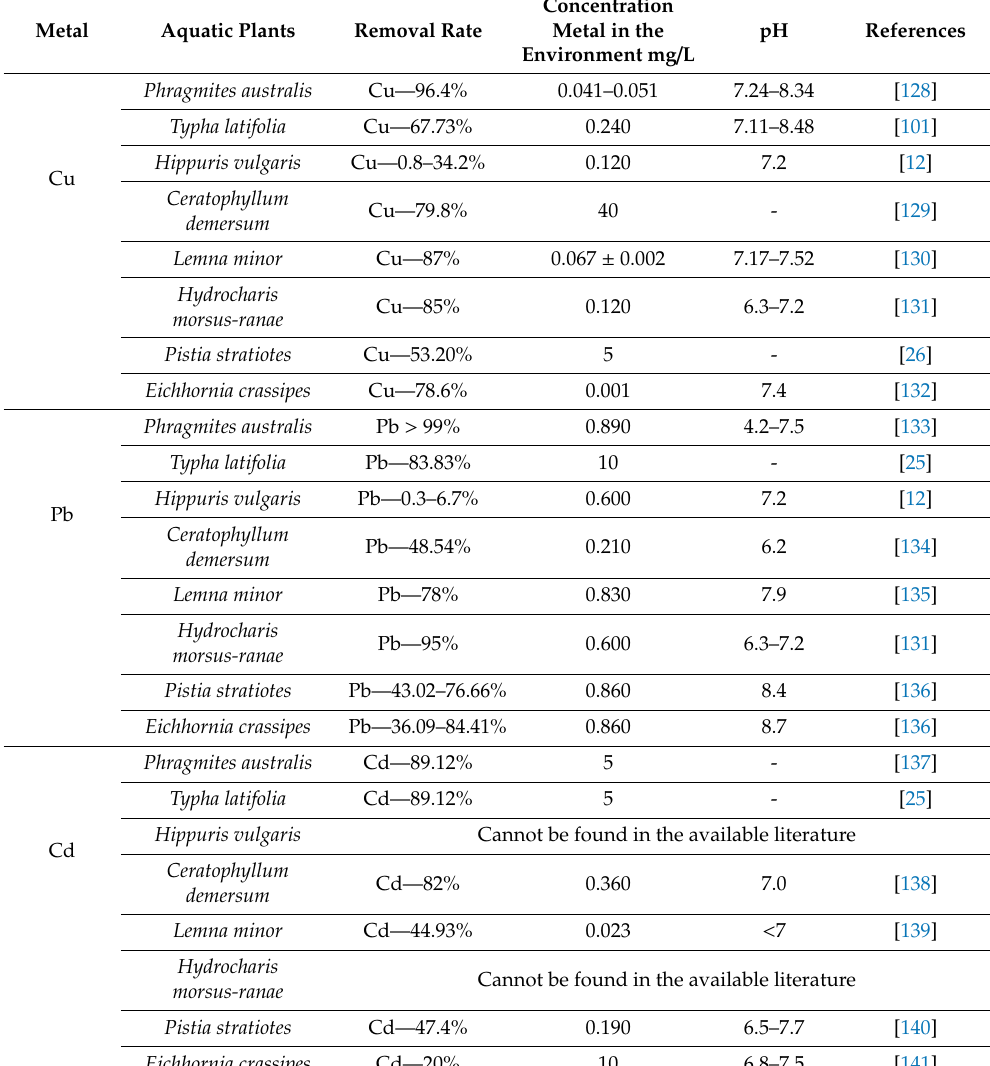
Table 3. Comparison of removal of metals by some water plants.